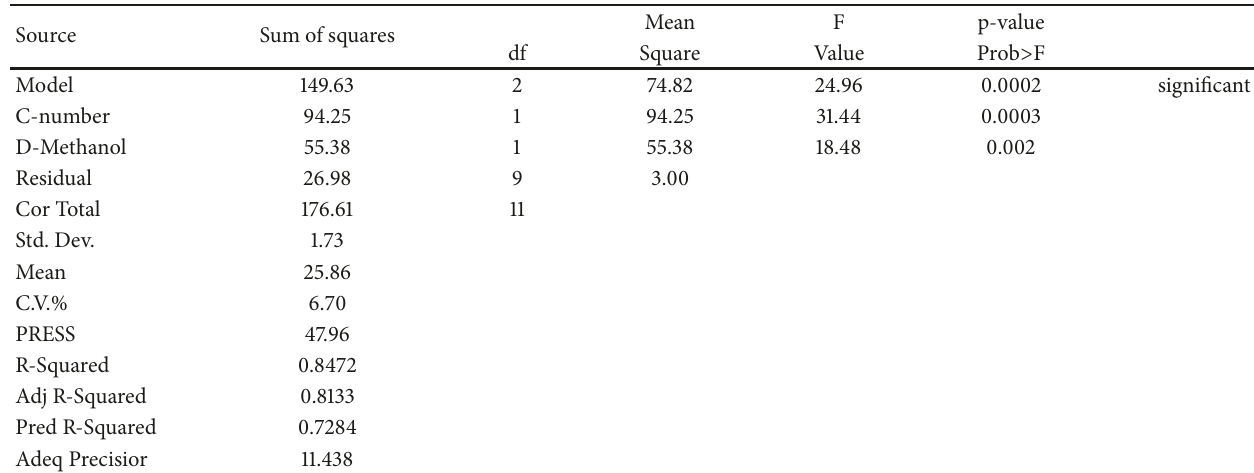
Table 5: ANOVA and R-squared for selected factorial